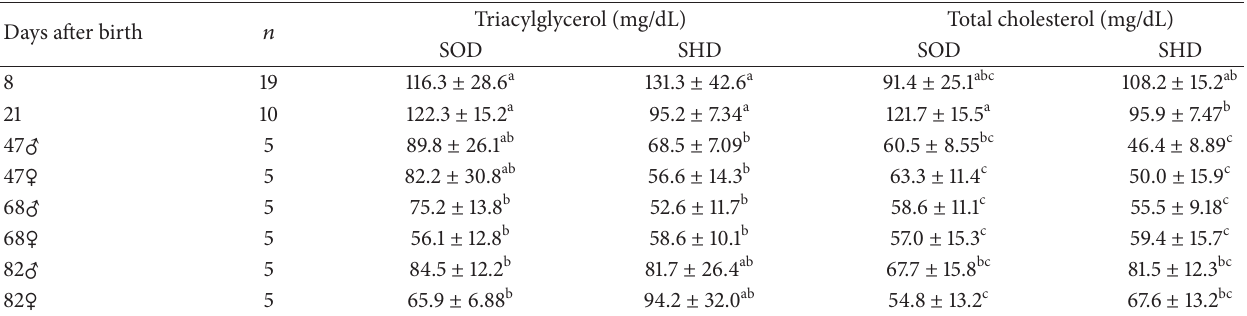
Table 6: Plasma lipid concentration of pups nursed by dams fed the soybean oil or shortening diet. Triacylglycerol (mg/dL) Total cholesterol (mg/dL) Days after birth 𝑛